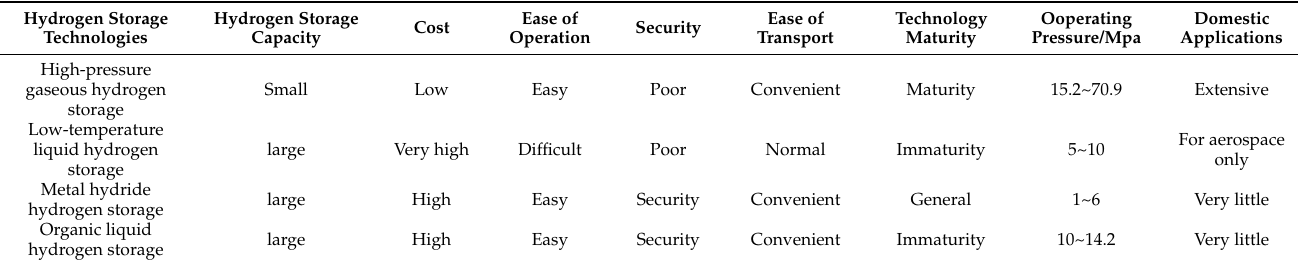
Table 7. Comparison of several hydrogen storage methods